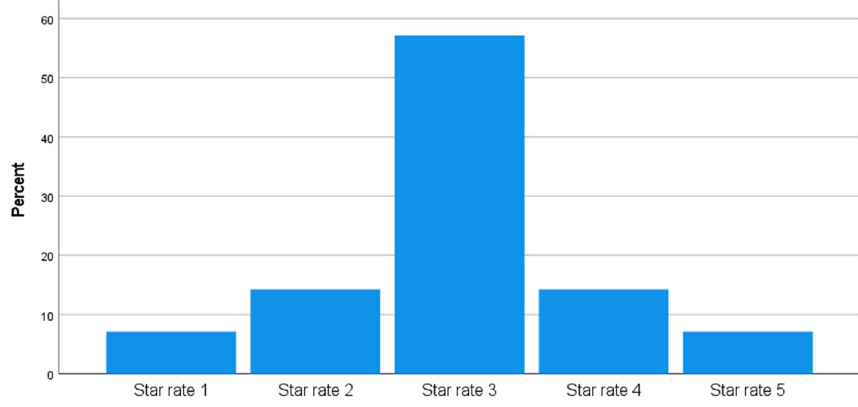
Fig. 7 Rate UK/EU Government understanding of the problem that Brexit and Covid has caused on continuous ro-ro freight movement?. Source Author